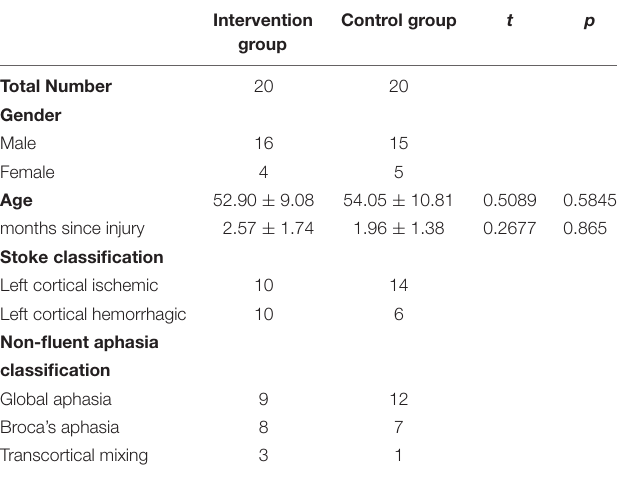
TABLE 1 | Participants’ characteristics in this